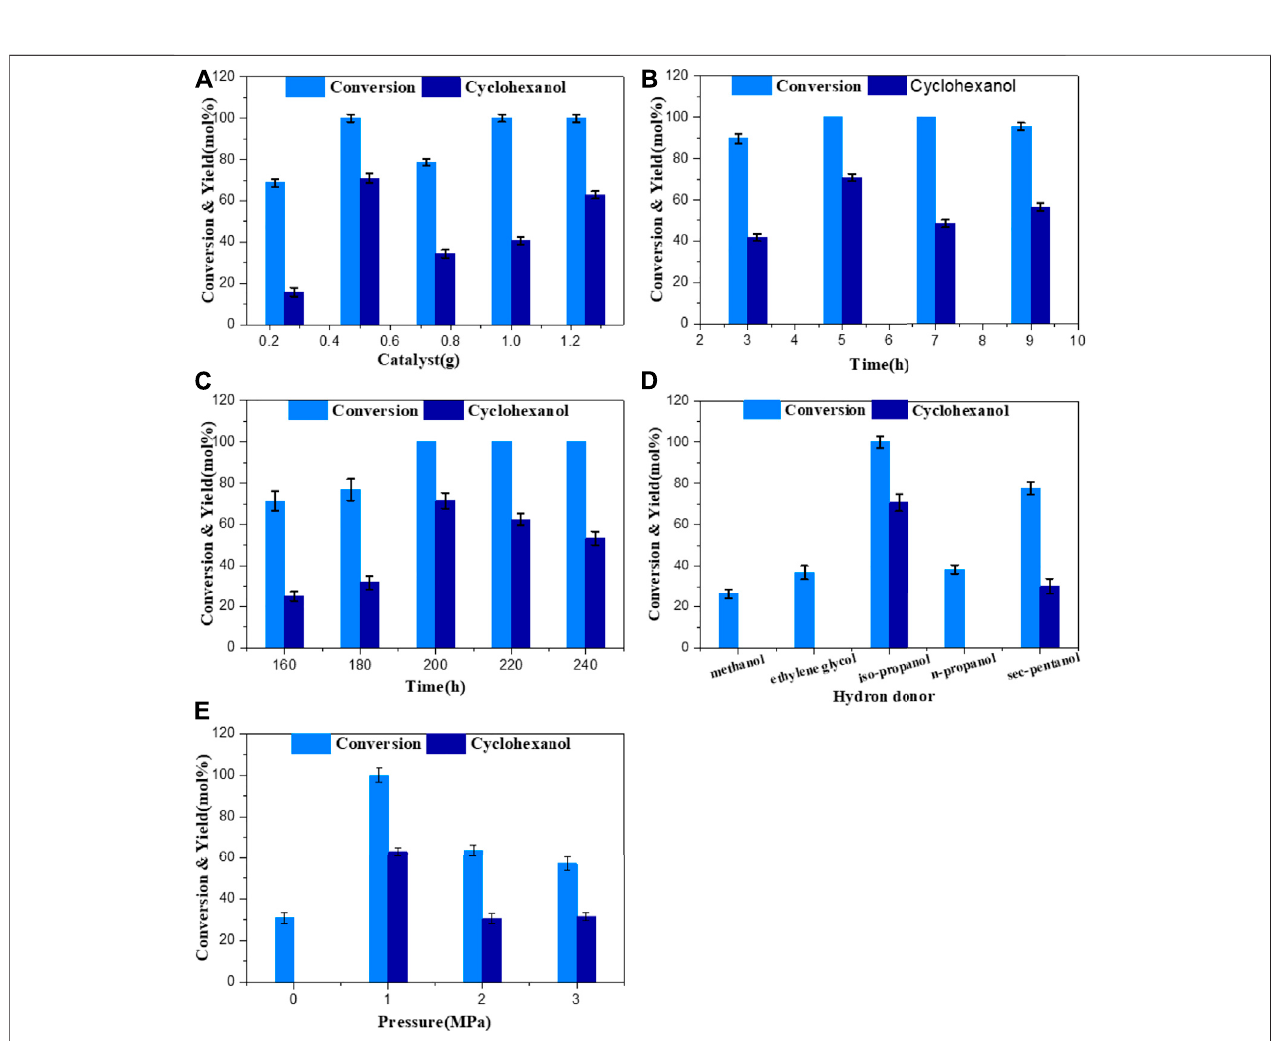
FIGURE 6 | Effect of (A) catalyst amount, (B) reaction time, (C) reaction temperature, (D) hydrogen sources, and (E) N 2 pressure on GUA conversion and main product yield. Reaction conditions: 1 g GUA and 0.5 g of 10Ni-10Mn/Nb 2 O 5.